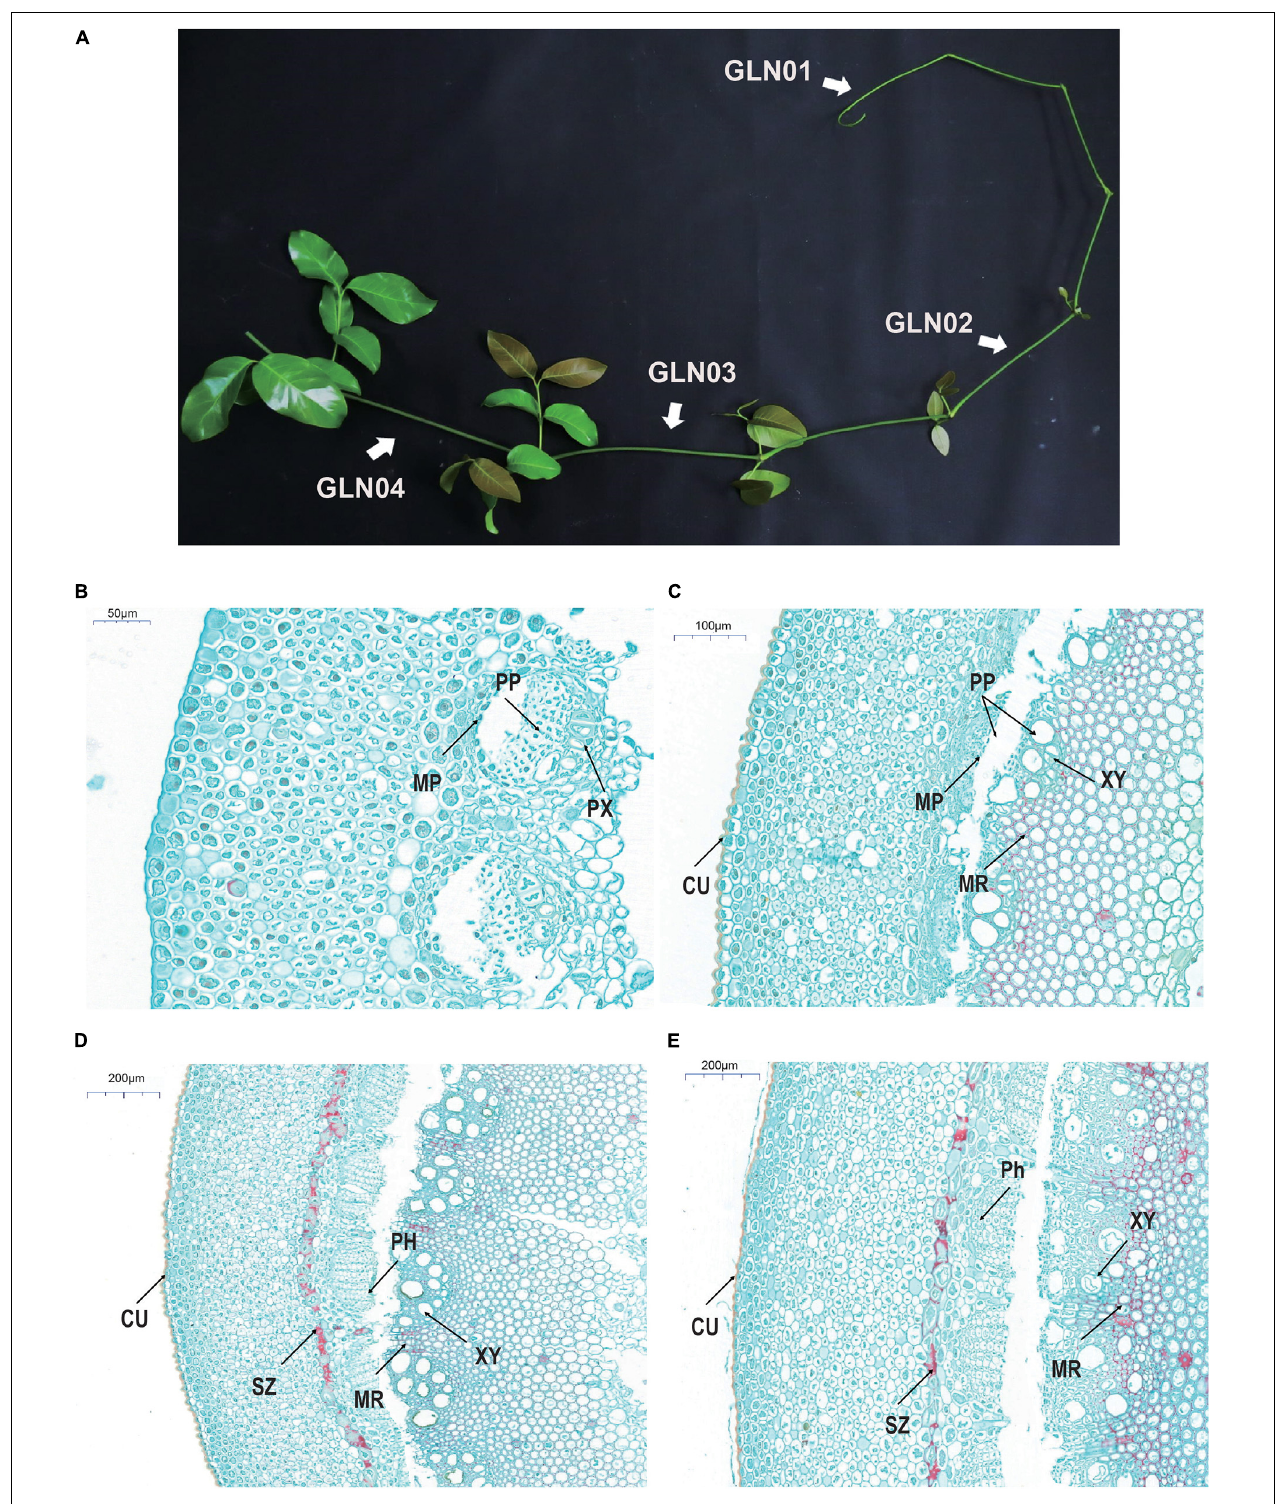
FIGURE 1 | Gross morphology and anatomical structures in G. luofuense stems. (A) A photograph shows four developmental stages (i.e., GLN01–04) of G. luofuense stems identified. (B–E) Anatomical structures and histology of G. luofuense stems at the developmental stages of GLN01 (B) , GLN02 (C) , GLN03 (D) , and GLN04 (E) . Abbreviations: CU, cuticle; MP, metaphloem; MR, medullary ray; PH, phloem; PP, protophloem; PX, protoxylem; SZ, sclerenchymatous zone; XY, xylem.